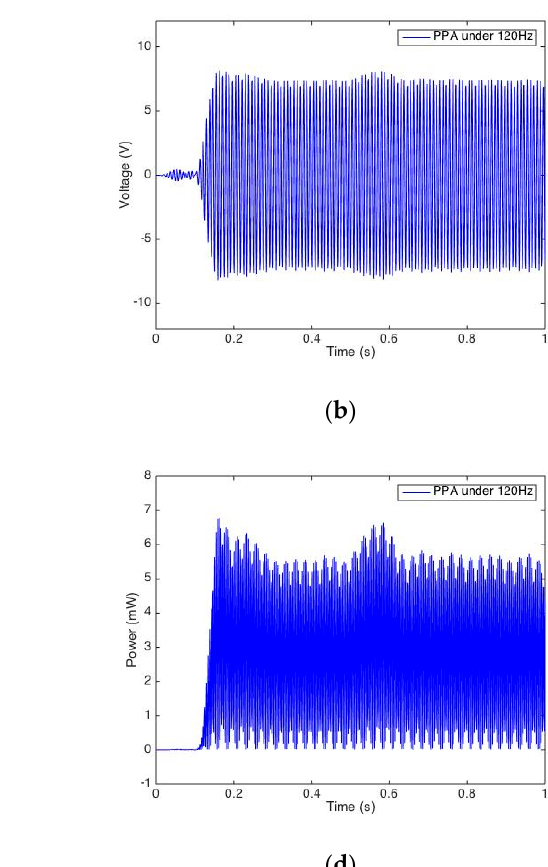
Figure 5. Mechanical and electric responses from MFC under resonant excitation. ( a ) Strain response for MFC under 60 Hz; ( b ) Voltage response for MFC under 60 Hz; ( c ) Current response for MFC under 60 Hz; ( d ) Power response for MFC under 60 Hz.